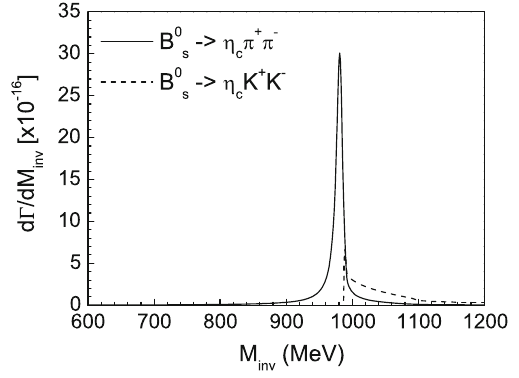
Fig. 3 π + π − and K + K − invariant mass distributions for ¯ B 0 s → + K η π + π − and η c c K